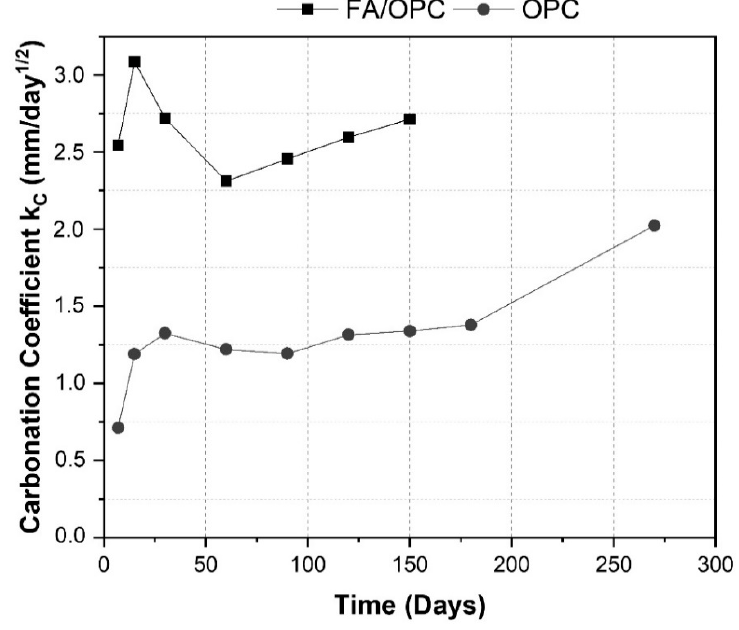
Figure 7. Concrete carbonation coefficient.